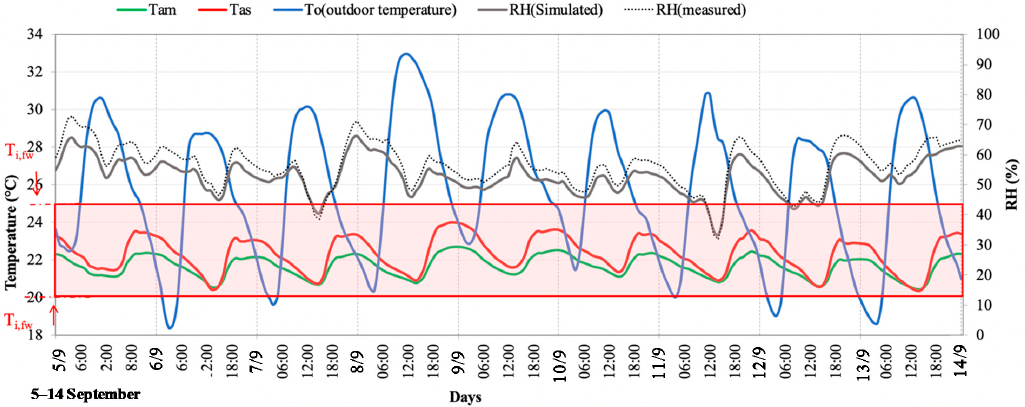
Figure 5. Daily profile of indoor temperatures at the current state of the building in free-running conditions during 5–14 September. conditions during 5–14